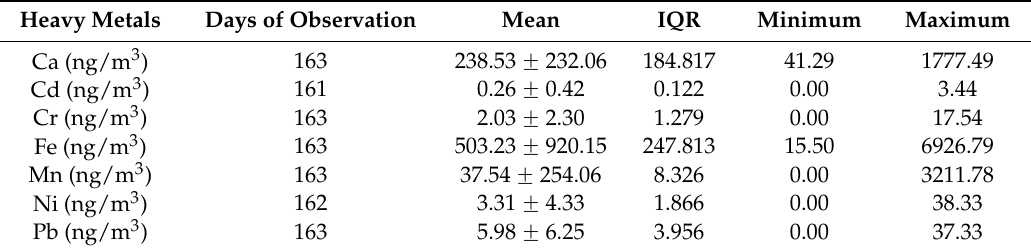
Table 2. Description of heavy metals from 4 January 2011 to 30 June